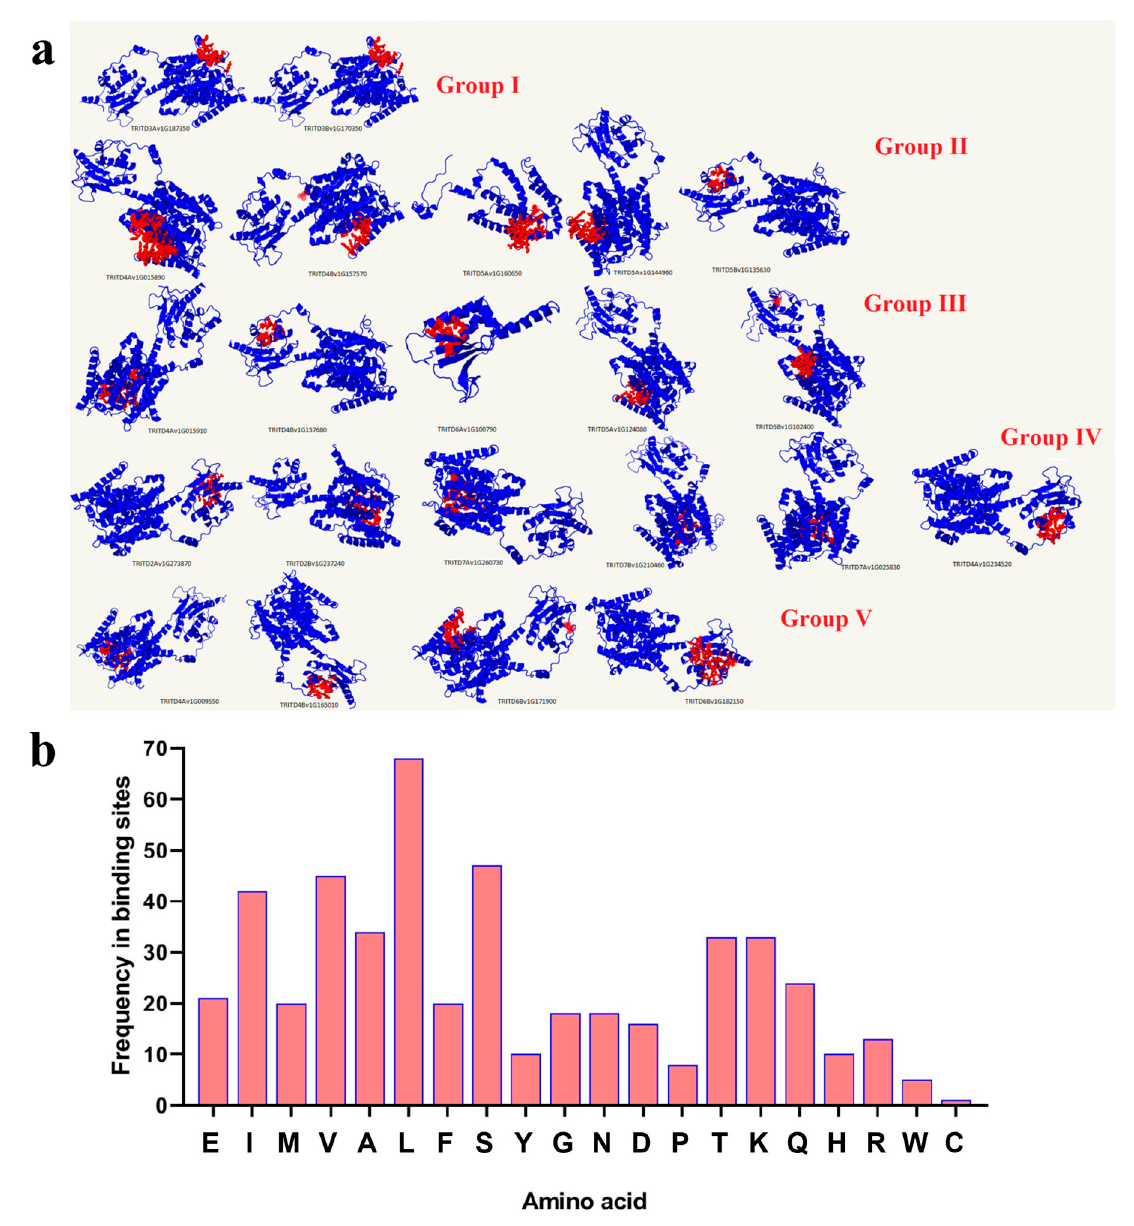
Figure 3. Three-dimensional and pocket site analysis of Td SULTRs in T. turgidum ( a ), and frequency of residues located in pocket sites of Td SULTRs ( b ). Red fill indicates the pocket site in the 3D structure of Td SULTRs. Abbreviations: Alanine, (Ala, A); Arginine, (Arg, R); Asparagine, (Asn, N); Aspartic acid, (Asp, D); Cysteine, (Cys, C); Glutamic acid, (Glu, E); Glutamine, (Gln, Q); Glycine, (Gly, G); Histidine, (His, H); Isoleucine, (Ile, I); Leucine, (Leu, L); Lysine, (Lys, K); Methionine, (Met, M); Phenylalanine, (Phe, F); Proline, (Pro, P); Serine, (Ser, S); Threonine, (Thr, T); Tryptophan, (Trp, W); Tyrosine, (Tyr, Y); Valine, (Val, V).